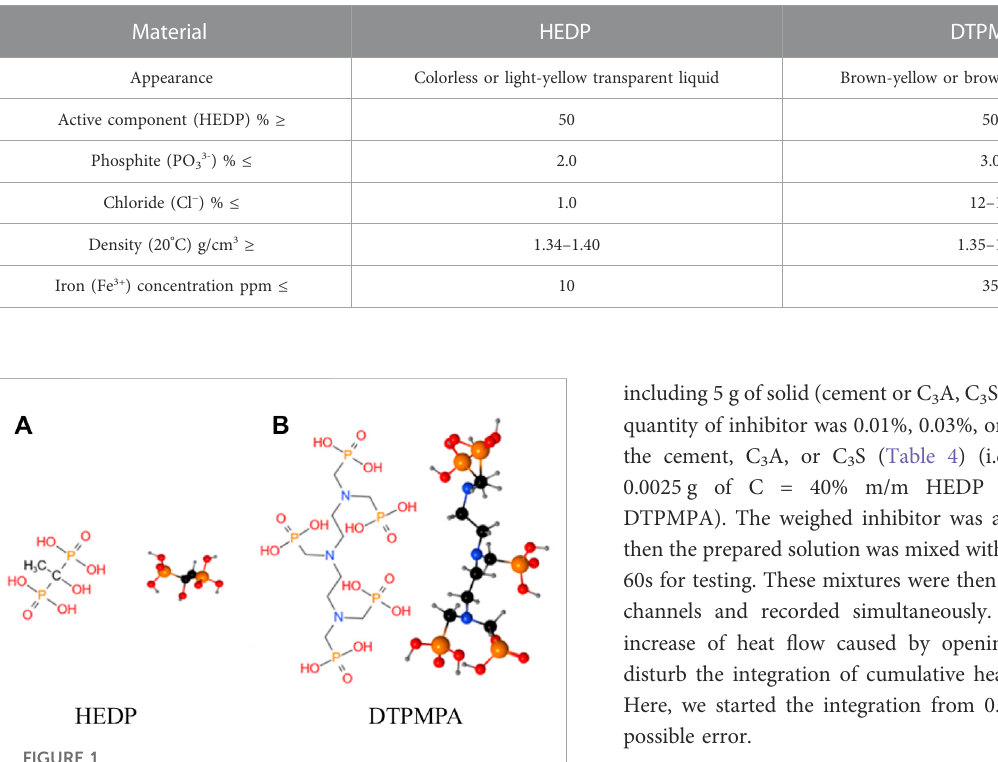
FIGURE 1 Molecular structures of the two inhibitors used in this study. (A) HEDP and (B)